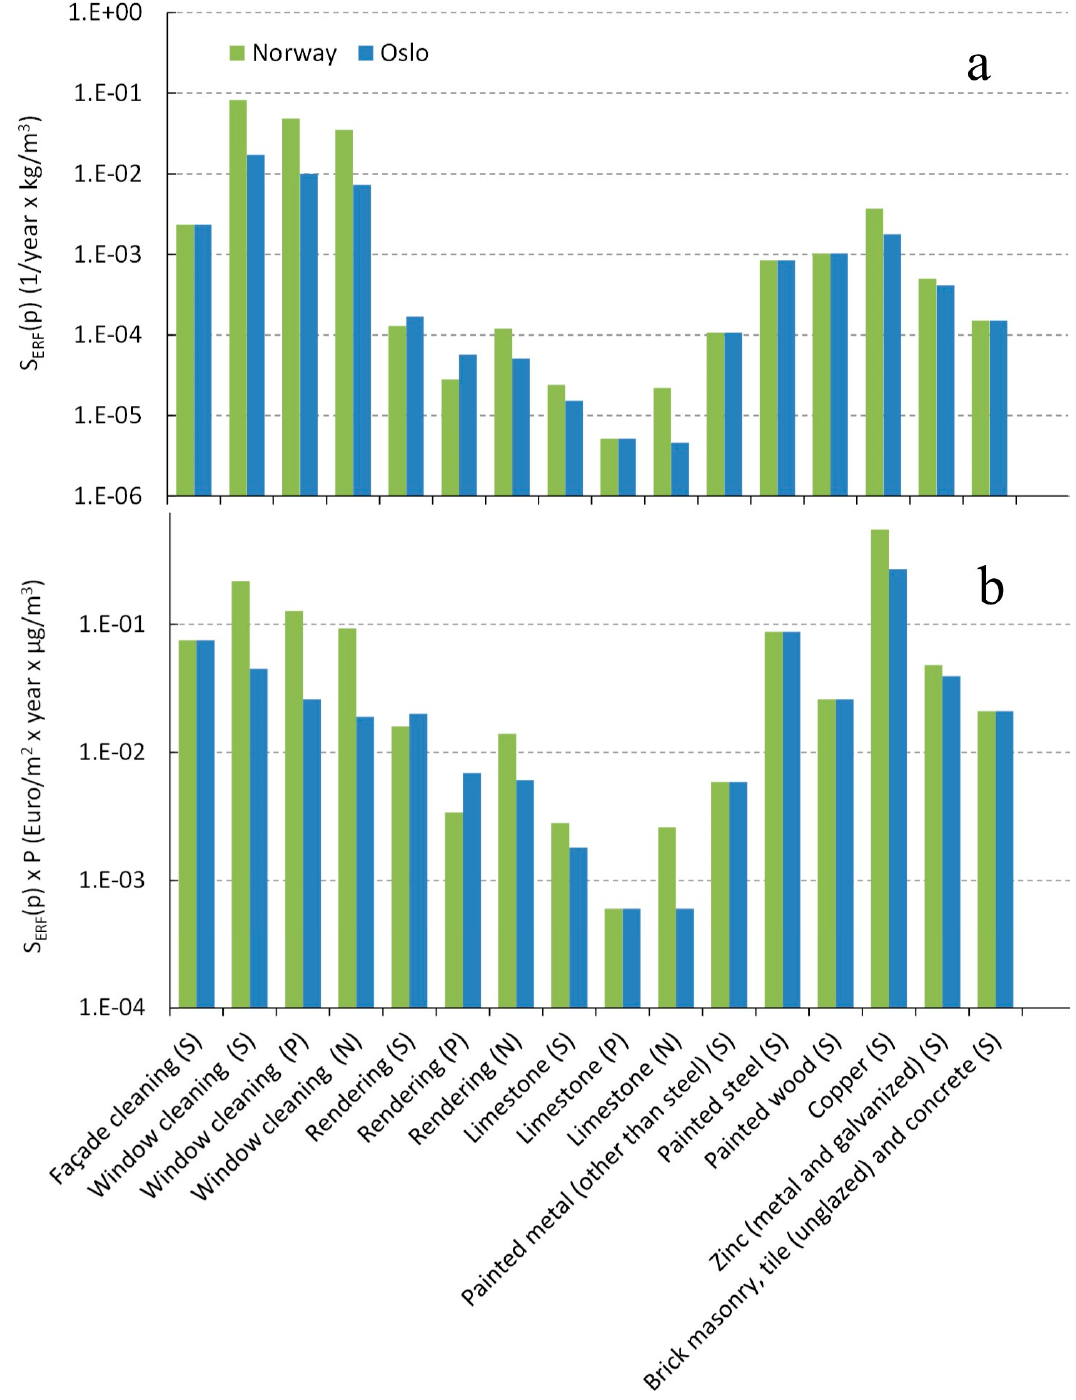
Figure 1. ( a ) Slopes of the ERFs (S ERF,p,i , 1 / year × kg / m 3 ), and ( b ) the marginal cost of the maintenance Figure 1. (a ) Slopes of the ERFs (S ERF,p,i , 1/year × kg/m 3 ), and ( b ) the marginal cost of the maintenance of the façade materials (S ERF,p,i × P, Euro / m 2 × year × µ g / m 3 ) for the air pollutants SO 2 (S), PM 10 (P), of the façade materials (S ERF,p,i × P, Euro/m 2 × year × µg/m 3 ) for the air pollutants SO 2 (S), PM 10 (P), and and NO 2 (N), in Norway and NO 2 (N), in Norway and Oslo.